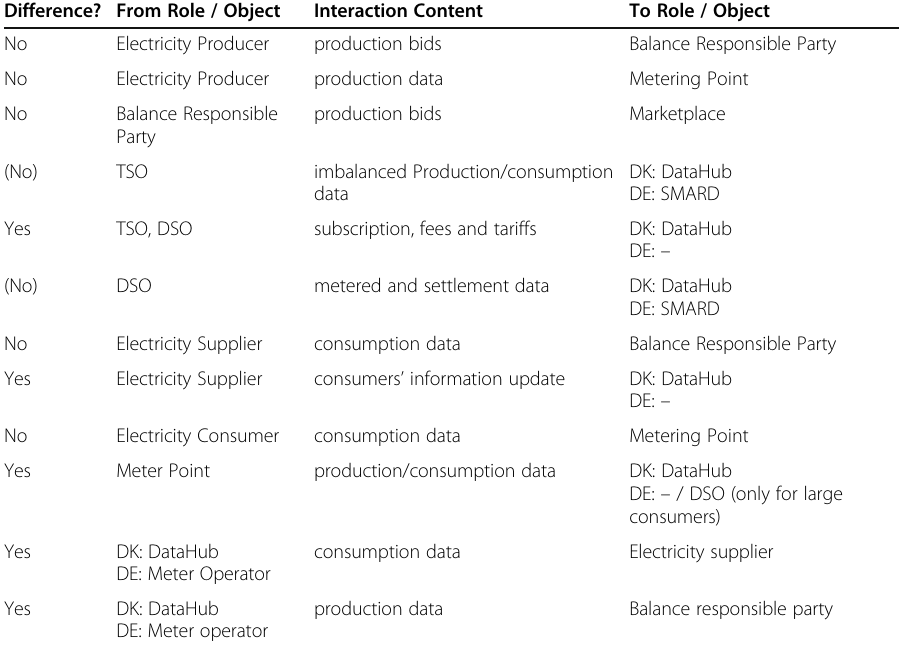
Table 4 Data and information interactions in the Danish and German electricity ecosystem (Bundesnetzagentur 2016; Bundesnetzagentur 2021a; Energinet 2020a) Difference? From Role / Object Interaction Content To Role /